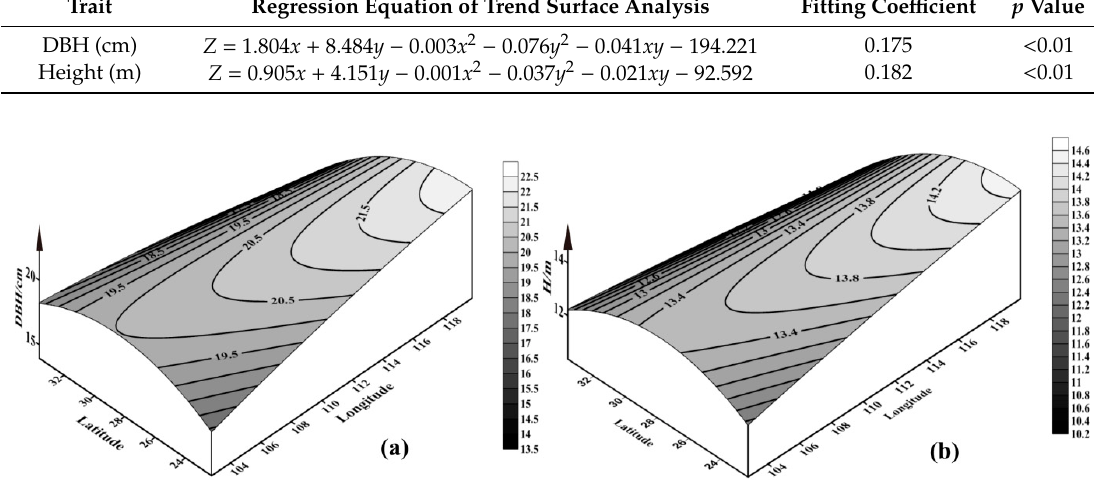
Table 4. Pearson correlation coefficients between climatic variables and the first four principal components, eigenvalues, and explained variance. Bioclimatic Variables Abbreviation